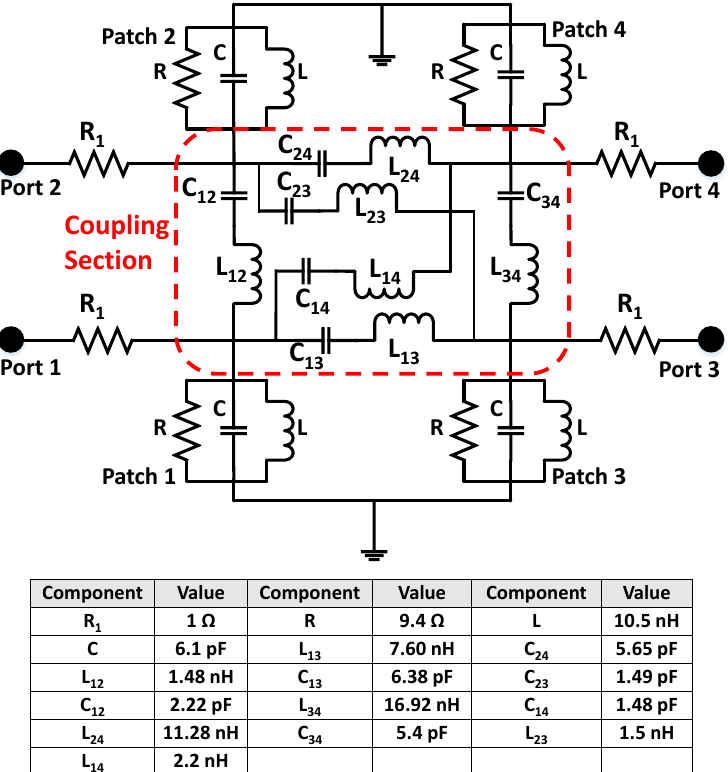
Figure 3. Equivalent circuit model of the MIMO antenna.